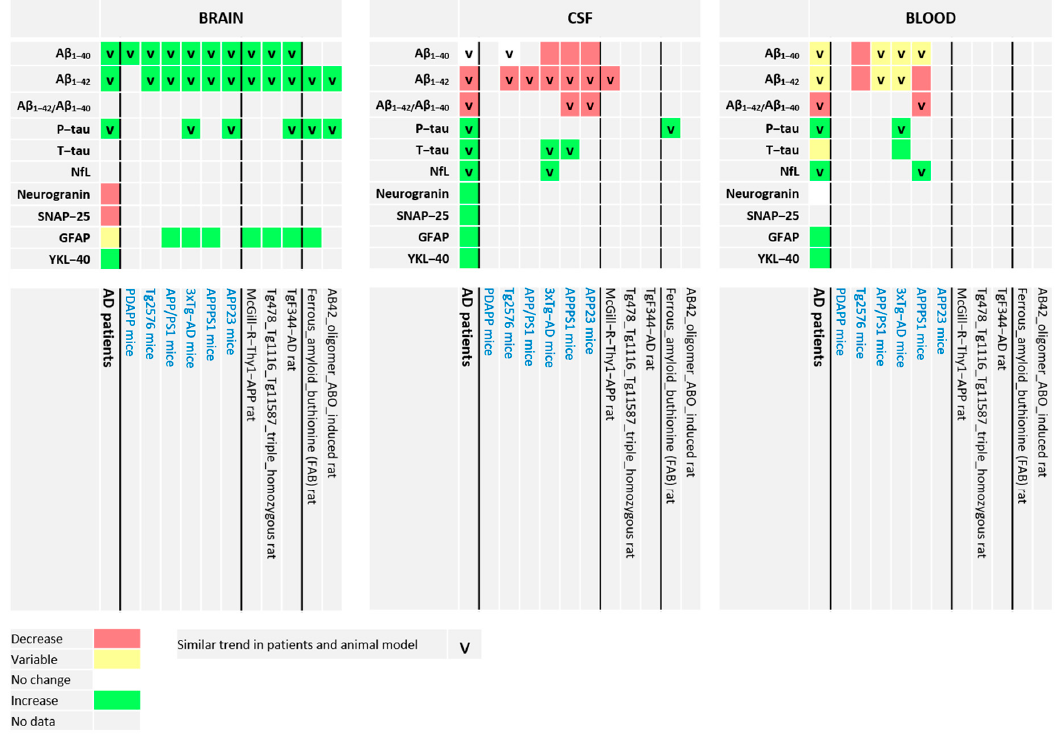
Figure 2. Heat map of the changes of the selected biomarkers measured in the brain, CSF, and blood in humans and different animal models of AD. In humans, the change in biomarker level is compared between AD patients and healthy volunteers. In AD animal models, the change in biomarker level is compared between “old” and “young” AD animals (different age groups) and therefore the change during life in which AD features are assumed to progress. Literature used: [50,52,55,78–144] (for details on values of individual studies please see also Supplementary Material 2).